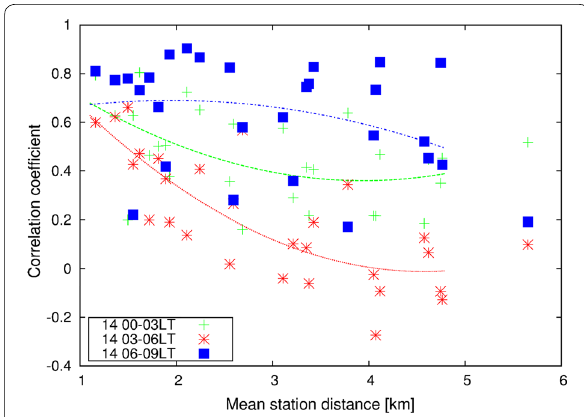
Fig. 5 Horizontal distance dependency of correlation coefficient of ZWD within the Uji network. The ZWD was converted from the SPD with the GNSS satellite at the highest elevation angle. Observa- tional periods during 0000–0300 LT (green), 0300–0600 LT (red), and 0600–0900 LT (blue) on August 14, 2012, corresponded to weak rain, heavy rain, and no rain periods at RISH, respectively. Curves are fitted